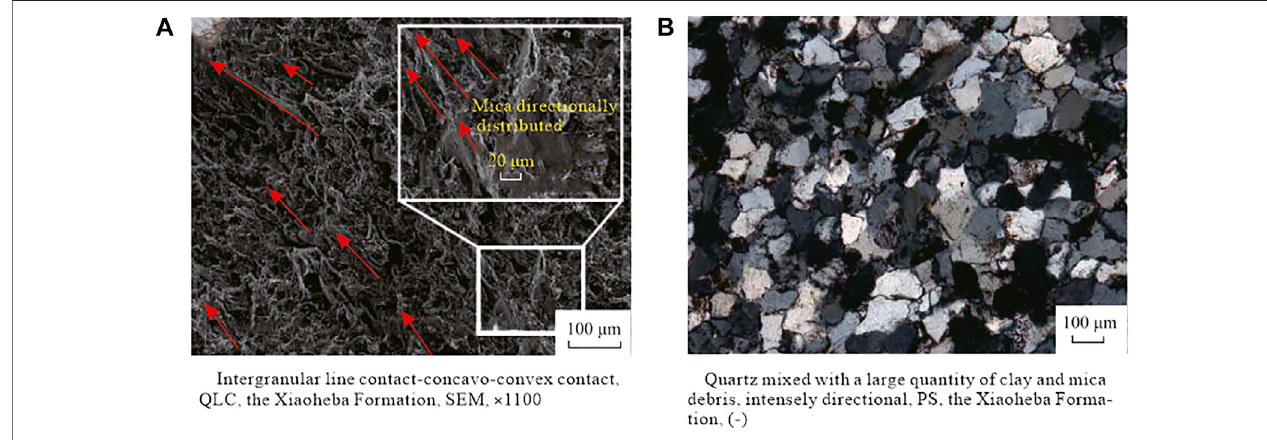
FIGURE 7 | Typical thin sections of the Xiaoheba Formation under compaction in Southeast Sichuan. (A) Mica directionally distributed, SQ, the Xiaoheba Formation, SEM, ×150; (B) Intergranular line contact — concavo-convex contact, PS, the Xiaoheba Formation, (+)